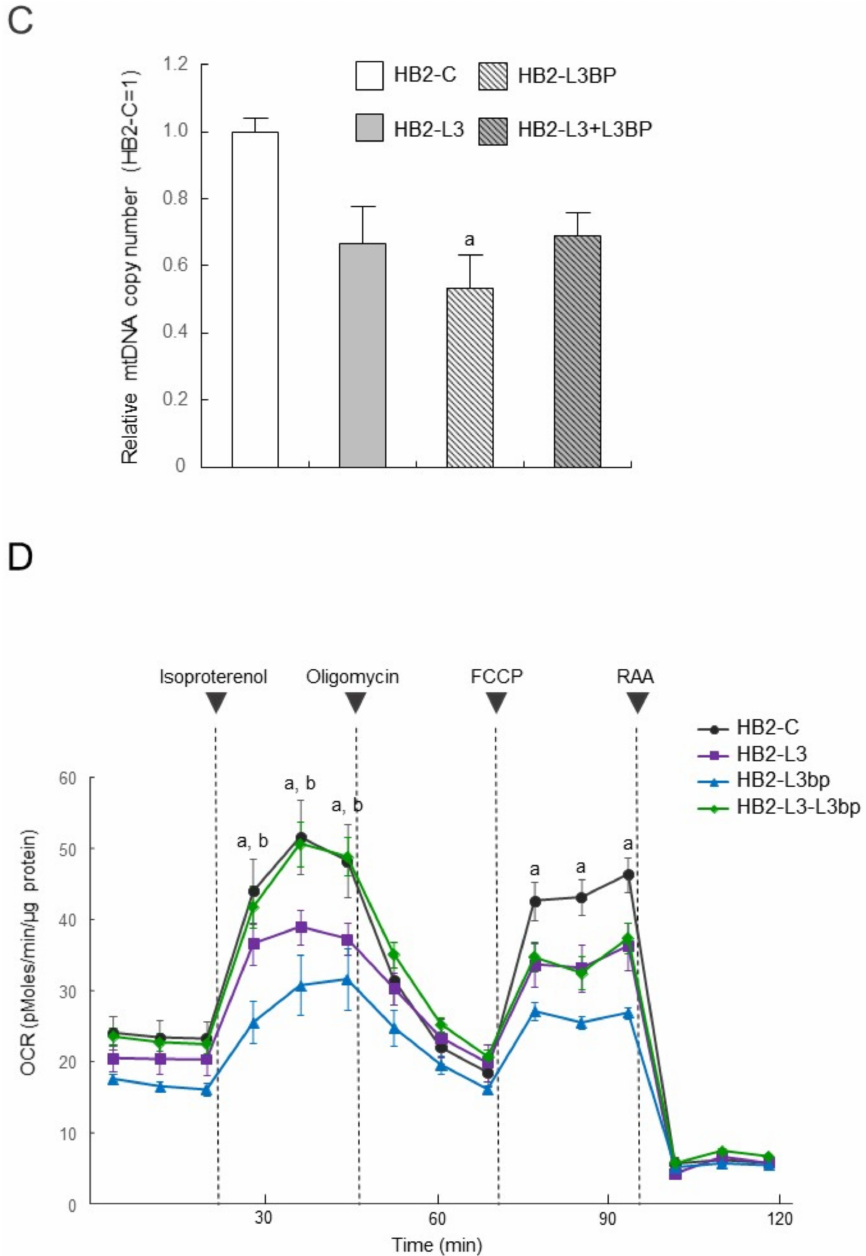
Figure 3. Effects of Lgals3 and Lgals3bp on the mitochondrial content in HB2 cells. ( A ) Intracellular mitochondria in HB2 transfectants during or after differentiation were stained red using a MitoTracker solution. Representative photomicrographs are shown. Each scale bar indicates 50 µ m. ED: early phases of brown adipocyte differentiation; MB: mature brown adipocyte. ( B ) Measured areas of staining using a MitoTracker per the number of Hoechst positive nuclei are calculated in three different fields of view. The mean ± SE values ( n = 3) are given: a p < 0.05 vs. HB2-C cells; b p < 0.05 vs. HB2-L3-L3bp cells; and c p < 0.05 vs. HB2-L3 cells. ( C ) The mtDNA copy number in mature HB2 transfectants. The mtDNA was amplified using the PCR protocol with primers that specifically amplify mouse mtDNA. The values shown in the bar graphs are related to an arbitrary unit of the HB2-C cells (set to 1), and the means ± SE values ( n = 3) are given: a p < 0.05 vs. HB2-C cells. ( D ) OCR in mature HB2 transfectants. OCRs were measured with the sequential injection of isoproterenol (1 µ m), oligomycin (5 µ m), FCCP (10 µ M), rotenone (R; 0.5 µ m), and antimycin A (AA: 0.5 µ m) at the indicated times. The means ± SE values ( n = 5) are given: a p < 0.05, HB2-L3bp cells vs. HB2-C cells; b p < 0.05, HB2-L3bp cells vs. HB2-L3-L3bp